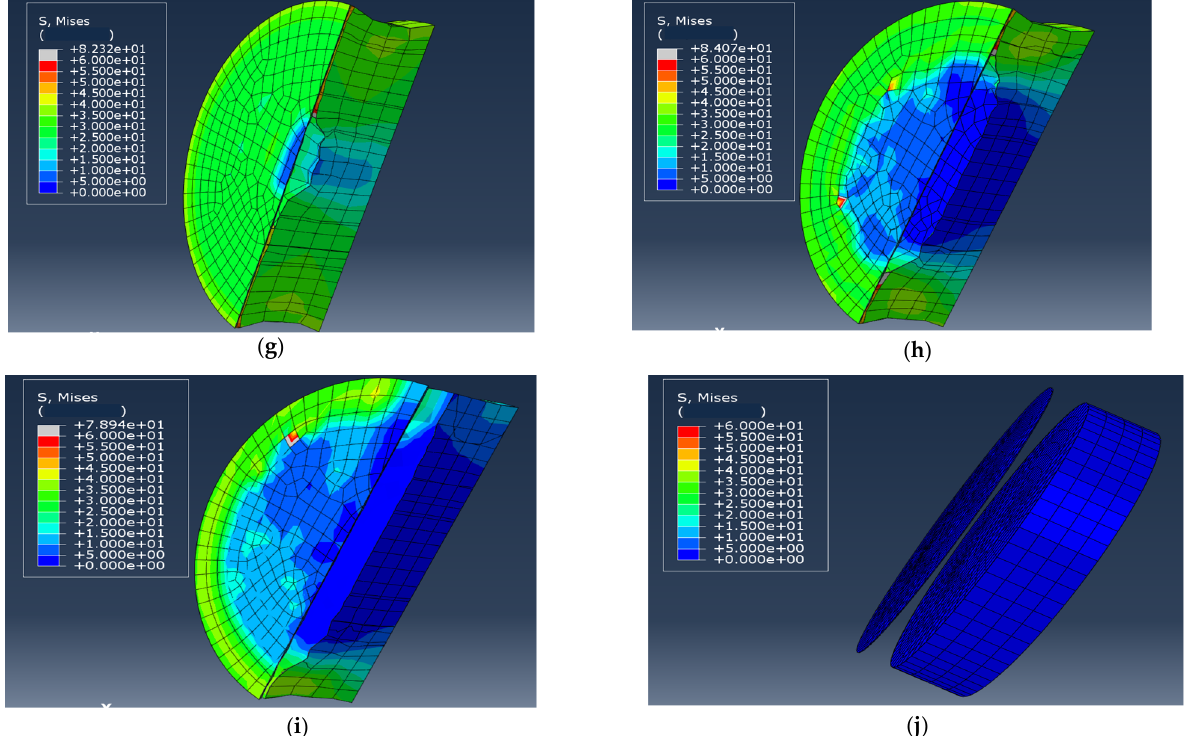
Figure 5. Mises stress evolution of the film/substrate structure under uniaxial tension with displacement loading from initial state ( a ) to complete interface fracture ( i ). ( a ) Mises stress at loading displacement 0, ( b ) at displacement 0.1302 µ m, ( c ) at displacement 0.2852 µ m, the stress increases continuously and becomes homogenous, the circumference stress is larger firstly, ( d ) at displacement 0.3774 µ m, the interface stress reaches the maximum value, ( e ) at displacement 0.3784 µ m after reaching the strength, the film stress begins to decrease, ( f ) at displacement 0.3787 µ m, the zone of stress drop localizes at the central firstly and through the substrate, the interface crack begins from the central (frontal, ( g ) cross-section), ( h ) at displacement 0.3819 µ m, the zone of stress drop extends from the central to the circumference, ( i ) at displacement 0.3834 µ m, the interface fracture is mostly complete, ( j ) complete separation between the film and substrate. unit of stress: MPa.